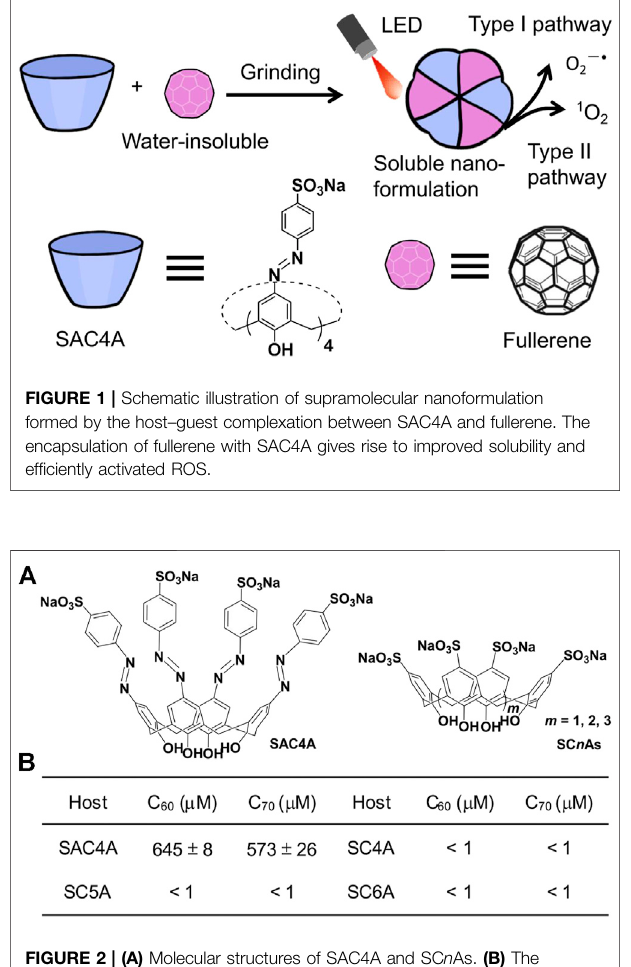
FIGURE 2 | (A) Molecular structures of SAC4A and SC n As. (B) The concentrations of C 60 and C 70 solubilized by calixarenes (1 mM for hosts).